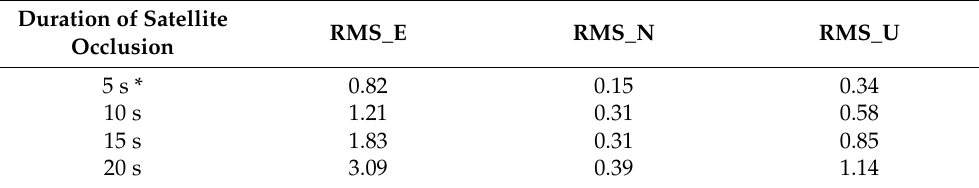
Figure 13. The RMS maximum value of two periods when simulating the landslide stability period in Scene 2.2. Table 7. RMS statistical results when simulating landslide sliding period in Scene 2.2 (unit: